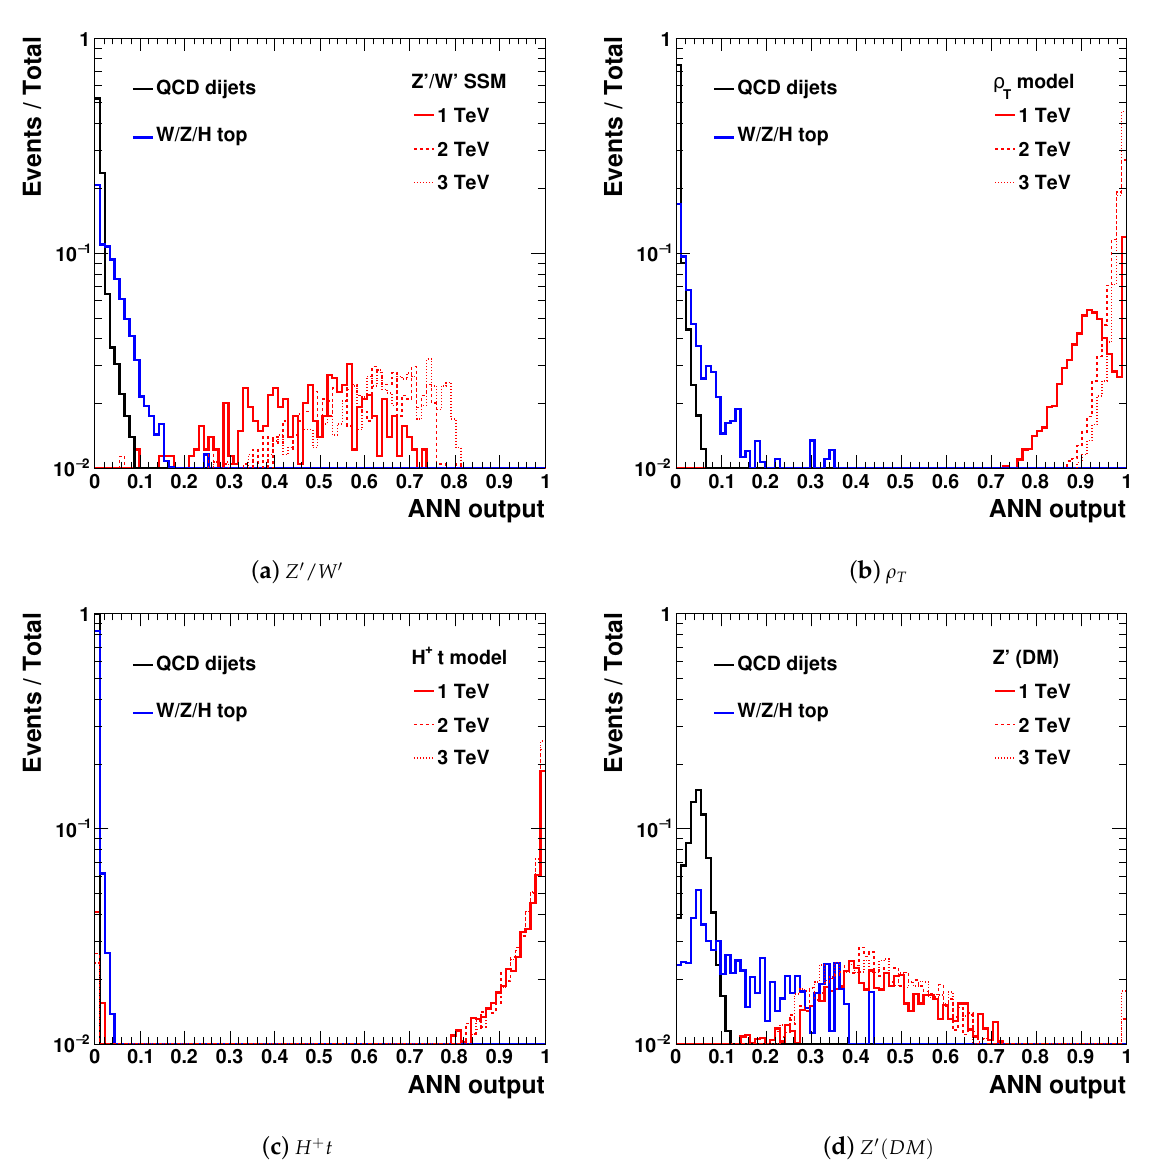
Figure 4. The artificial neural network (ANN) output scores for the output nodes of the beyond Standard Model (BSM) models for the background (thick black and blue solid lines) and those corresponding to the BSM model for different mass assumptions (red lines). The pp collision events were generated using Pythia8 after parton showers and